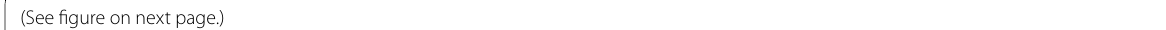
(See figure on next page.) Fig. 4 Overexpressing E-cadherin inhibits PC3-TxR and DU145-TxR cell migration and invasion and partly restores paclitaxel sensitivity. a